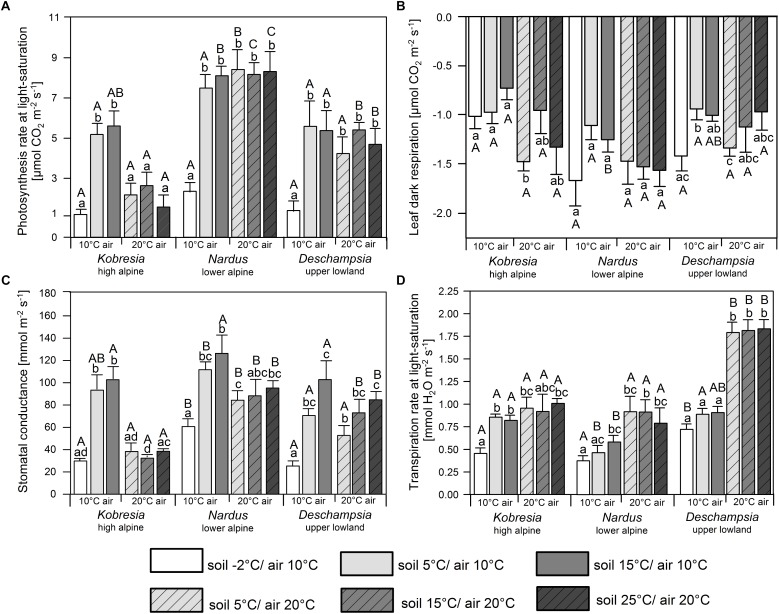
(A) Photosynthesis at light saturation (1500 μmol photons m-2s-1), (B) leaf dark respiration, (C) stomatal conductance, and (D) transpiration at light saturation of Kobresia pygmaea, Deschampsia flexuosa, and Nardus stricta in the two air temperature (10 and 20°C) and four soil temperature (–2, 5, 15, and 25°C) treatments. Small letters indicate significant differences (p ≤ 0.05) between treatments for one species. Capital letters indicate significant differences (p ≤ 0.05) between species within a treatment. Error bars indicate standard errors, n = 6.